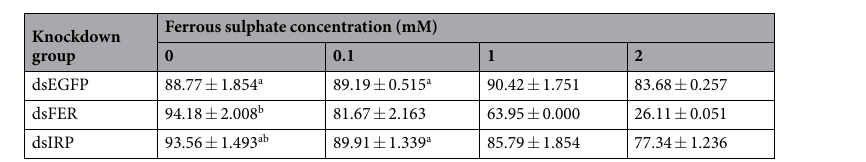
Table 6. Proliferation (%) of knockdown cells exposed to different concentrations of ferrous sulphate at 48 h. Data are presented as mean ± S.D. The results for the normality and homogeneity are presented in Table S16. A one-way ANOVA with Bonferonni multiple comparison test was performed (Tables S17 and S18). Statistical significance was set as * P < 0.05. Columns with the same superscript are not significantly different at P < 0.05. The data presented are results of three separate experiments with two technical replicates for each